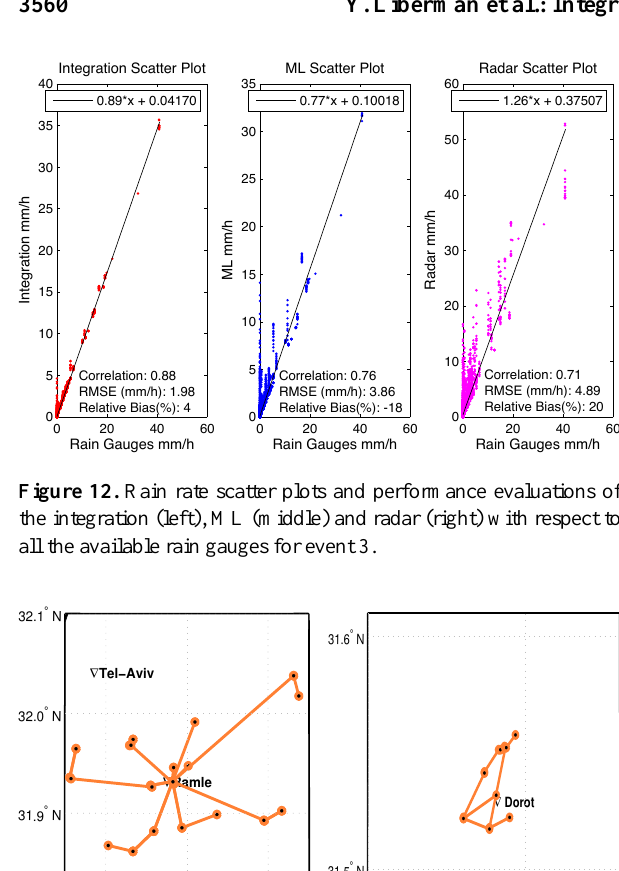
Fig. 14. Rain rates scatter plots of the Integration (left), the ML (middle) and the radar (right) with respect to theraingaugeinRamlesiteforevent(1).